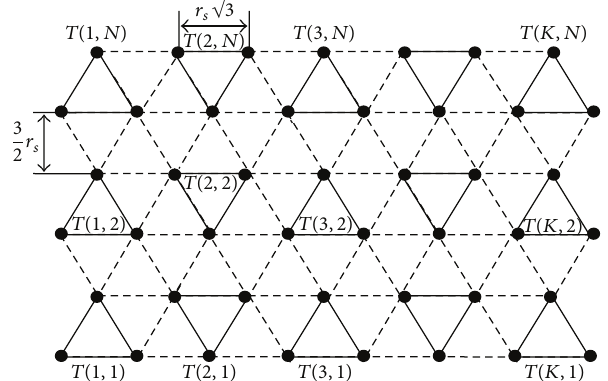
Figure 1: Triangular grid